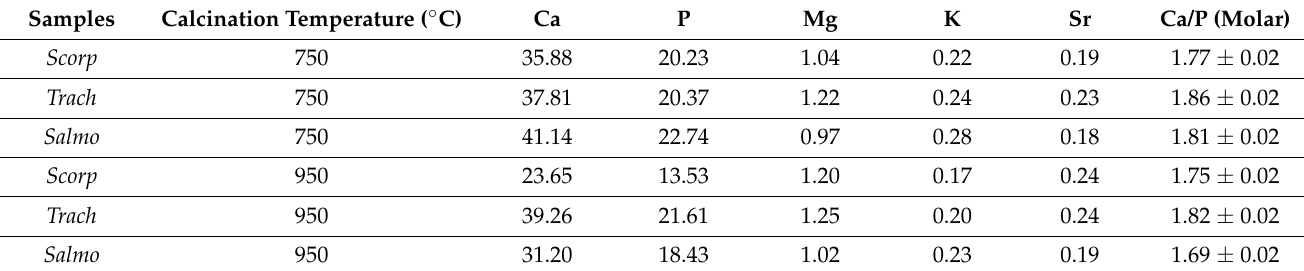
Table 3. Elemental composition of the samples at 750 and 950 ◦ C and their corresponding Ca/P ratio. Samples Calcination Temperature ( ◦